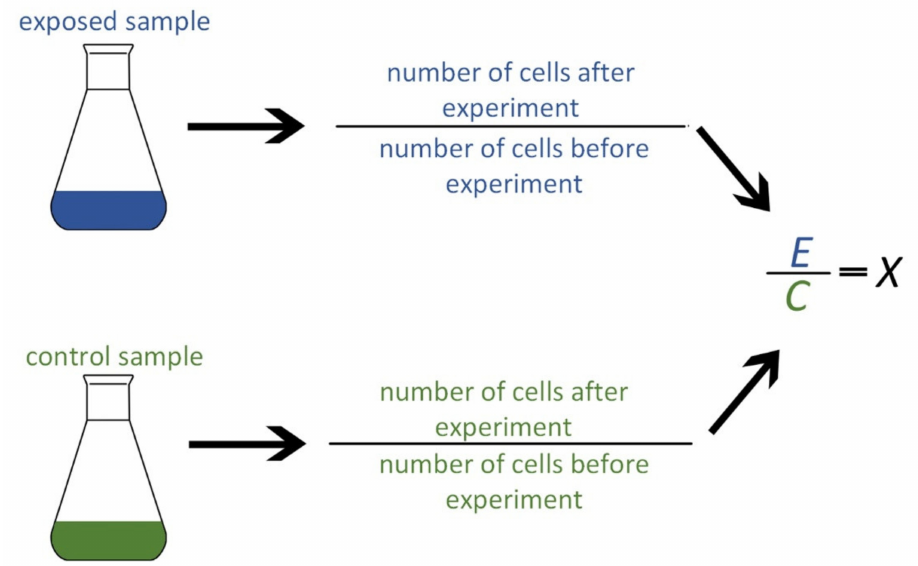
Figure 10. The procedure for determining the effect of